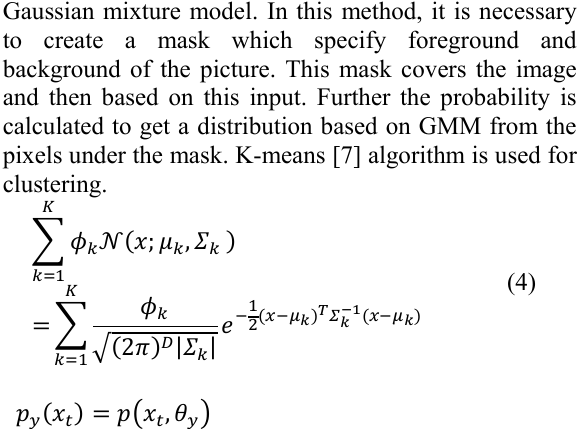
Fig. 7. Histogram of the masked pixels from the original image.